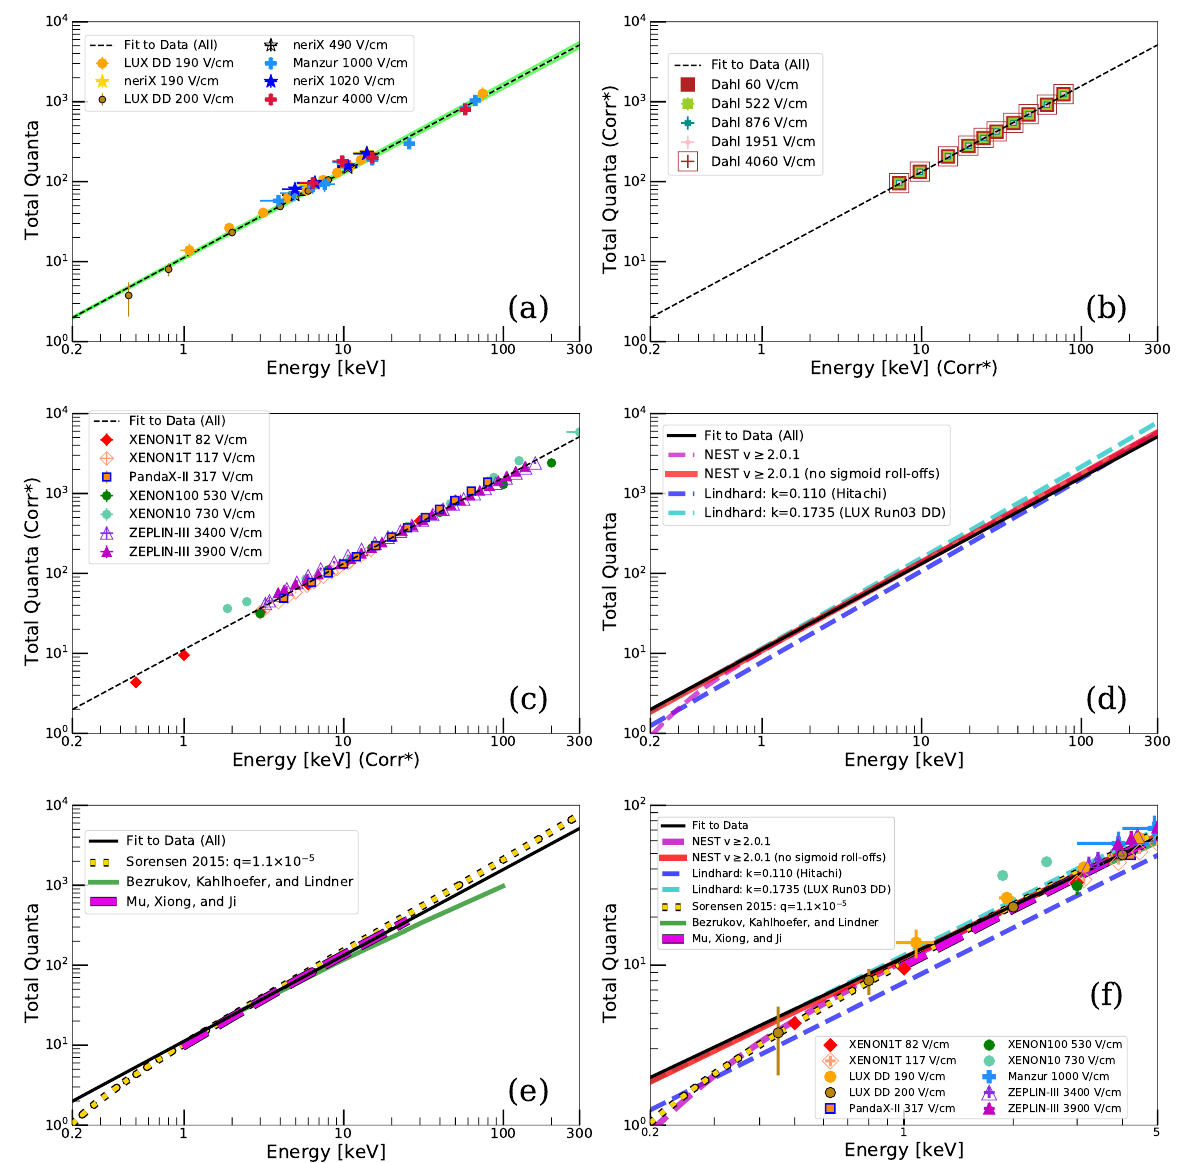
Figure 5. All available world data on LXe NR at time of writing summarized in one place, with N ph and N e − combined into N q . Where the E s did not match up (sometimes even within the same data set), a simple power law was used to spline (only interpolate not extrapolate) the numbers of photons first to add them to electrons. E-field does not cause measurable differences. ( a ) Only directly measured yields using angular measurements to determine E [27,30,121,122]. These are handled as more “trustworthy” in the community due to being quasi-monoenergetic analyses, and thus given the most weight in the fit even if there were fewer points. One simple power law appears to describe the data points across over three orders of magnitude in E , depicted as the black line, dashed or solid, within every plot pane. For ( a ), an uncertainty band was included (2 σ for clear visualization in green, not 1 σ ). ( b ) Dahl’s thesis data from the Xed detector taken from broad-spectrum shape spline fits ( 252 Cf) [36]. * Corr(ected) on the y-axis refers to correcting the data in our global meta-re-analysis for effects often not known at the time of data-taking, such as the 2-photoelectron (phe) effect, or the extraction efficiency being much less than 100% than the data-takers had originally estimated [16,123,124]. The former can lower the L y measurements, depending on the analysis technique, while the latter raises Q y data points typically. The x-axis was corrected in the sense of energy estimates updated with a more modern combined- E scale whenever possible. ( c ) More (indirect) measurements from continuous source bands, from XENON, ZEPLIN, and PandaX [35,56,68,80,125–130]. Errors in data used whenever reported. ( d , e ) A review of models [27,48,131–135]. ( f ) Low- E zoom of models, with data included, as larger-size